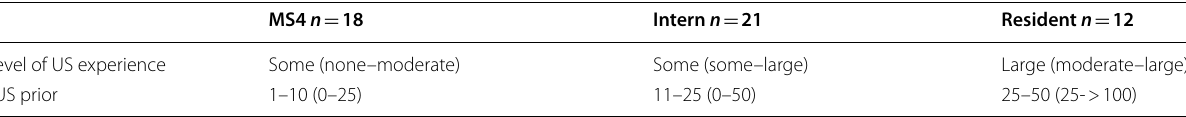
BMI body mass index, ICU intensive care unit, HF heart failure, HFpEF heart failure with preserved ejection fraction